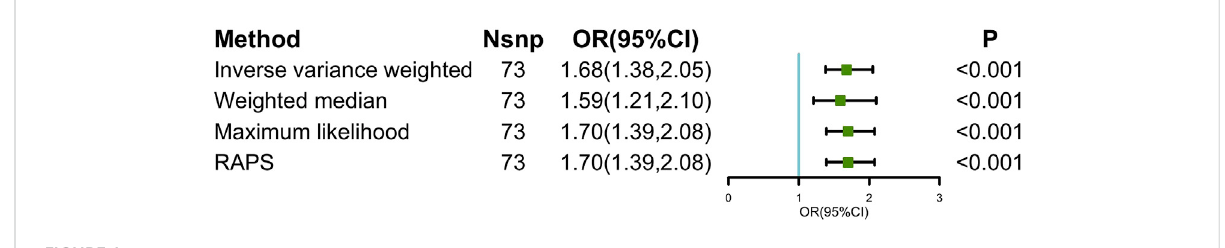
FIGURE 1 Causal estimates of depression on ED in MR. Abbreviations: ED, erectile dysfunction; MR, Mendelian randomization; Nsnp, number of single- nucleotide polymorphism used in MR analysis; OR, odds ratio; CI, con fi dence interval; RAPS, robust adjusted pro fi le score.